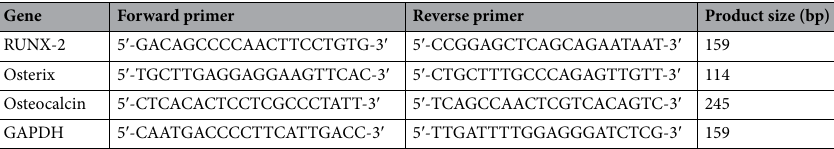
Table 1. The primers and the product